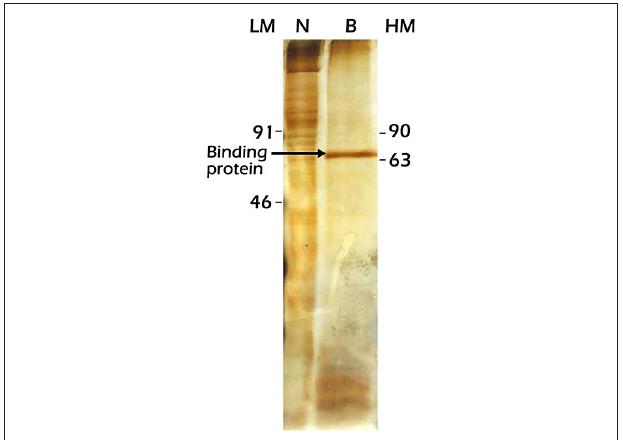
FIGURE 8 | Sodium dodecyl sulfate-polyacrylamide gel electrophoresis (SDS-PAGE) separation and silver staining of the protein precipitated from the previtellogenic female fat body nuclear extracts by the 31-bp Vg2 RE wild-type sequence. Lane LM: Low molecular weight protein markers, lane N: total nuclear extracts, lane B: protein pulled down by the 31-bp Vg2 RE, and lane HM: High-molecular-weight protein